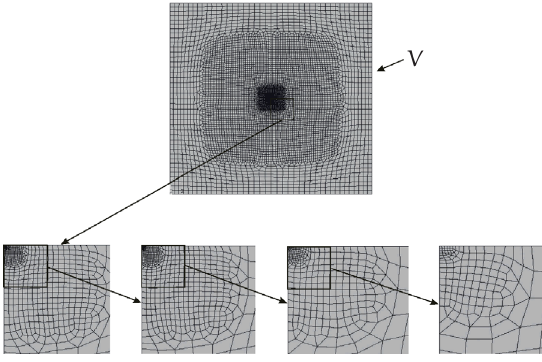
Figure 3.1. The triangulation of V with 28207 nodes and 9350